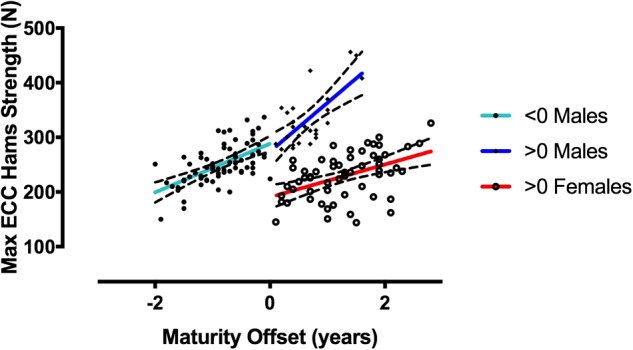
Correlations between MEHS and maturity offset is represented by 0 value. Males < 0: r = 0.59, r2 = 0.35, p < 0.0001; Males > 0: r = 0.70, r2 = 0.49, p < 0.0001; and Females > 0: r = 0.46, r2 = 0.22, p < 0.0001.